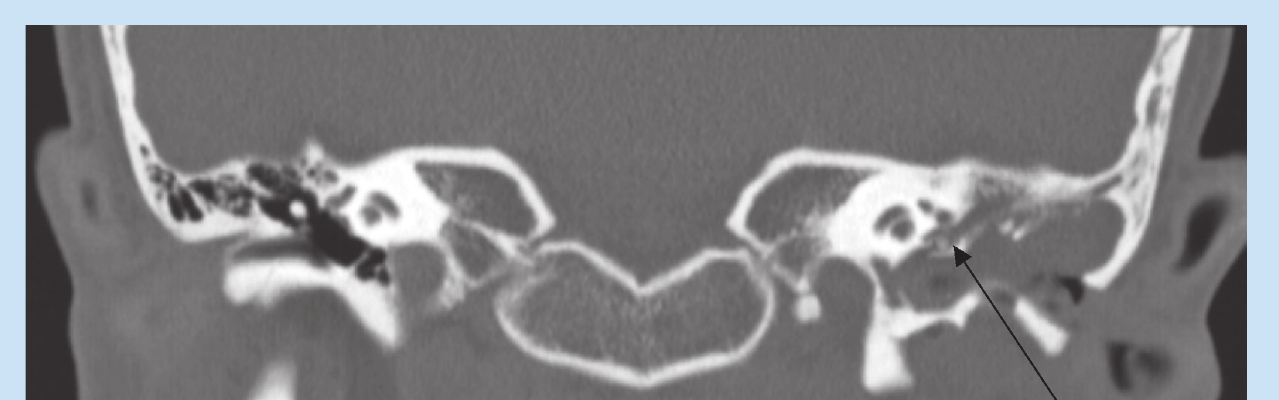
Fig. 4. Coronal CT with semi-circular erosions